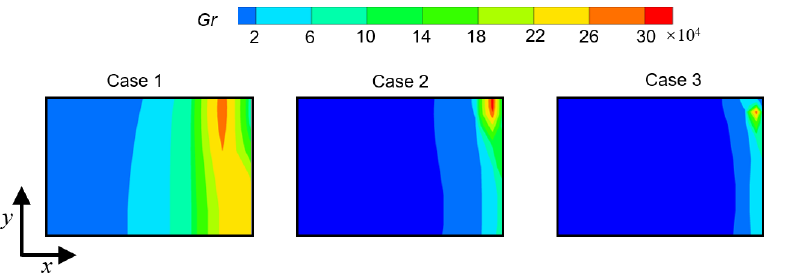
Figure 8. Distribution of the Gorashov number and characterization of the flow of buoyant forces in Case 1, Case 2, and Case 3.